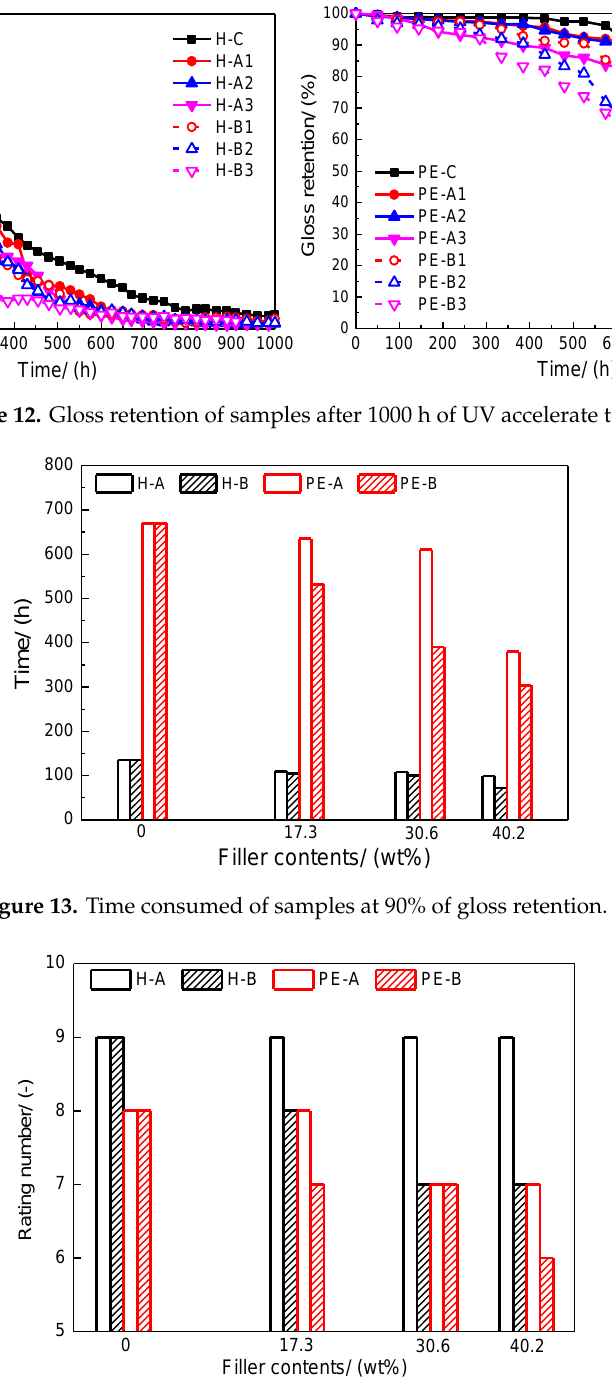
Figure 14. Rating number of failures at scribe of samples after 1000 h of salt spray test.